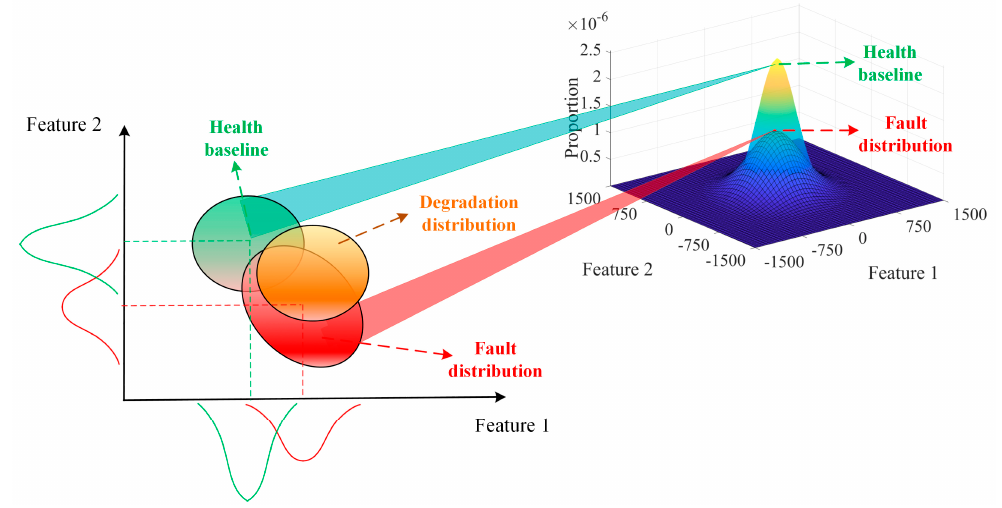
Figure 4. Schematic diagram of the feature distribution.